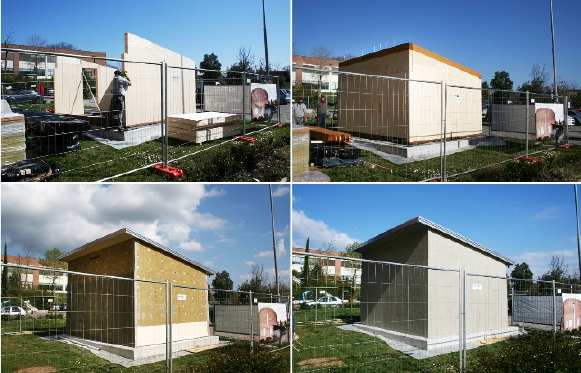
Figure 3. Different construction phases of the test